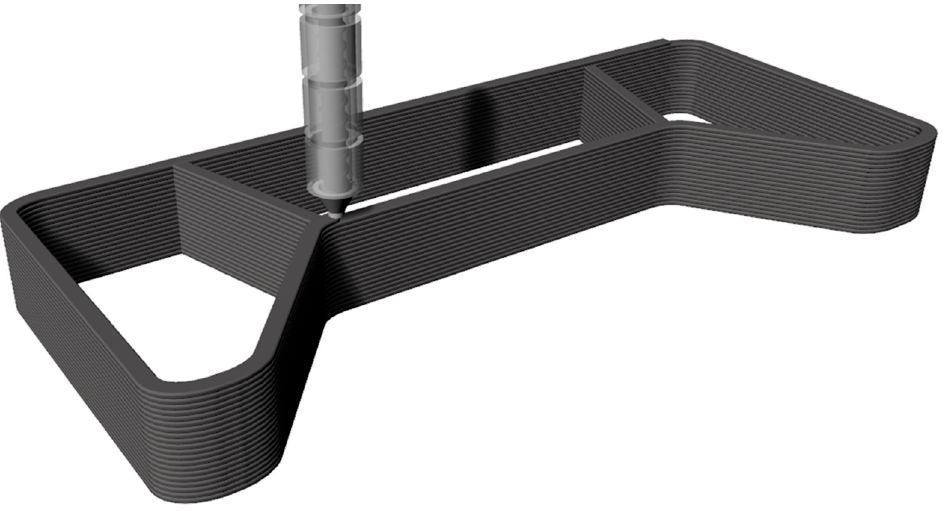
Figure 4. CNC extrusion process of thermoplastic granulate filled with carbon fibers.